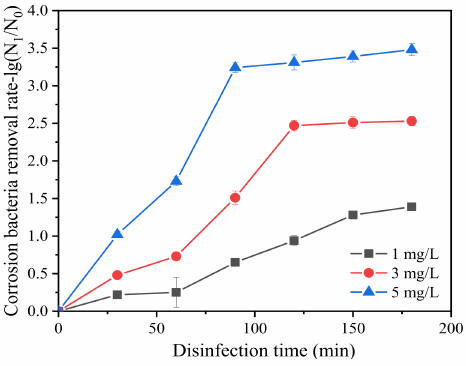
Figure 4. Correlation between chlorine concentration and corrosion bacteria removal.